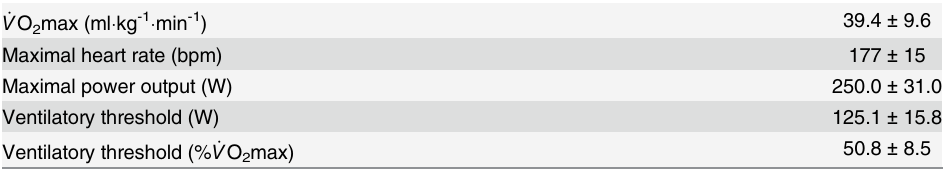
Table 1. Measured parameters during maximal cycling incremental test (n = 11).